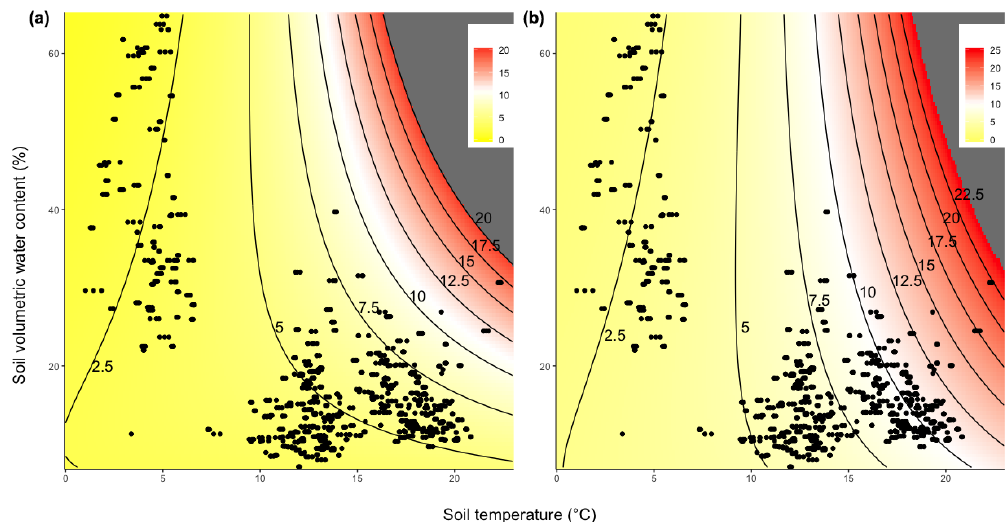
Figure 3. CO 2 efflux (µmolCO 2 m − 2 s − 1 ) modelled as a function of soil temperature and SWC in (a) ambient plots and (b) warmed plots. Colour indicates predicted CO 2 efflux values, and field observations are shown as individual points. Regions beyond the observed range of CO 2 efflux rates are shown in grey.